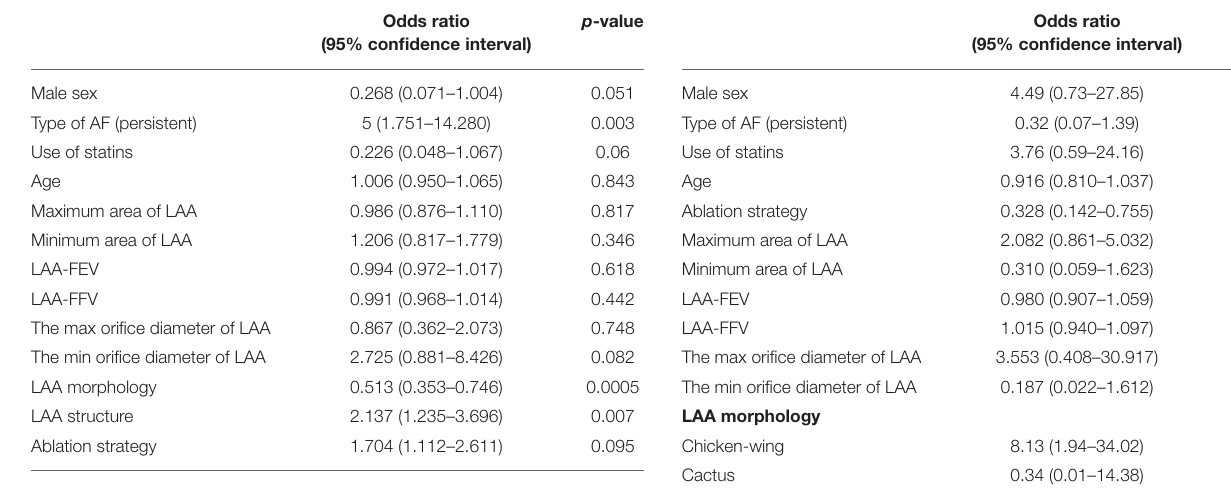
TABLE 7 | Univariate logistic regression analysis for variables with AF recurrence.